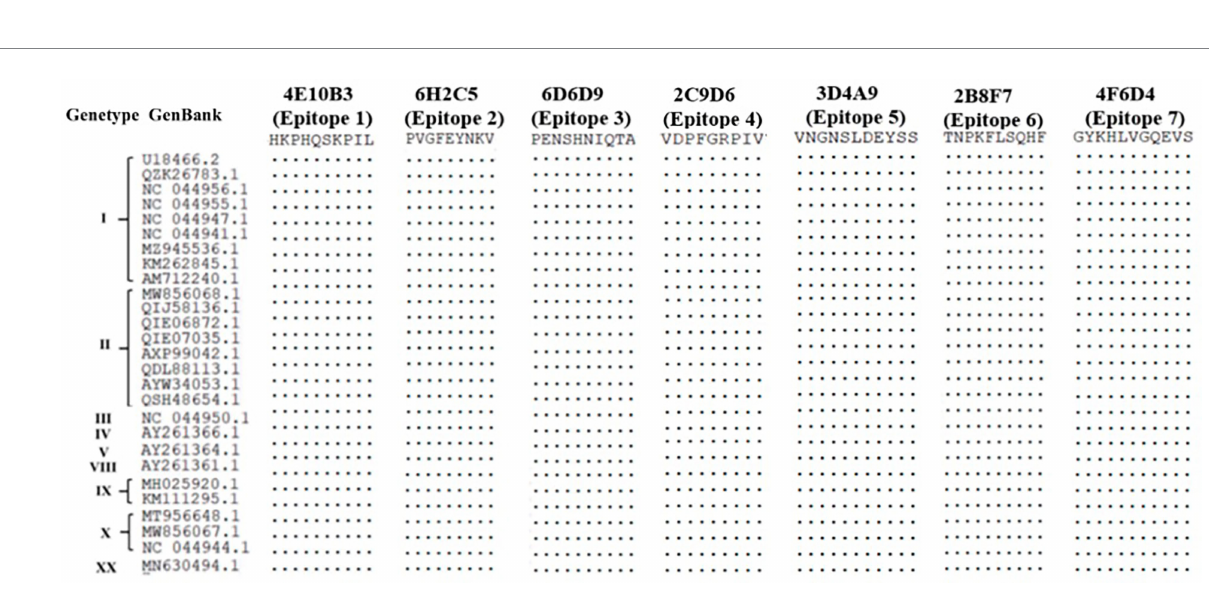
FIGURE 7 Sequence comparison of phenotypes identified using the 17 mAbs with different ASFV genotypic